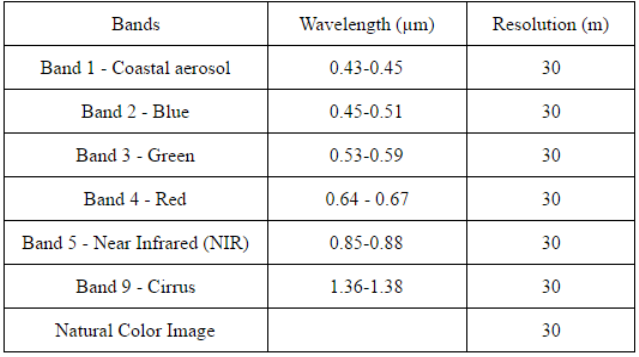
Figure 4: Characteristics of Landsat 8